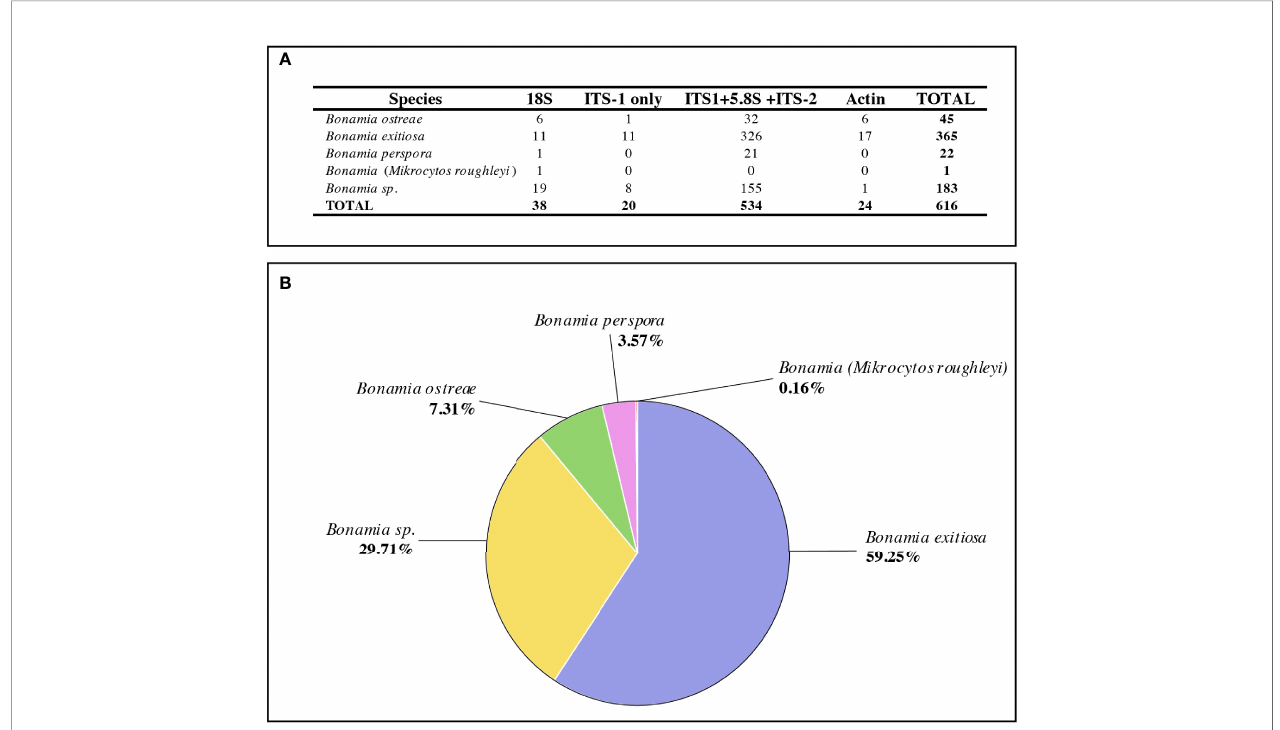
FIGURE 1 | Overview of Bonamia sequence data available in public databases. (A) Number of nucleotide sequences available in NCBI for protists of the genus Bonamia. (Source: NCBI, August 03, 2021, Query: Bonamia, output has been checked, removing nonrelevant sequences). (B) Percentages of nucleotide sequences available for protists of the genus Bonamia in NCBI by species (Source: NCBI, August 03, 2021, Query: Bonamia, output has been checked, removing nonrelevant sequences).